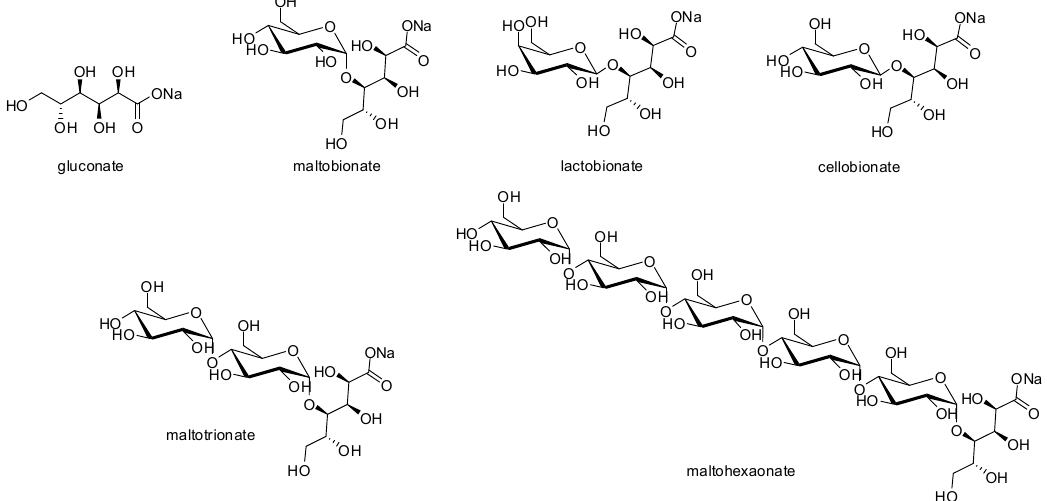
Figure 5. Products obtained by photocatalytic selective oxidation of various oligosaccharides after 10 min of standardized sunlight illumination (A.M.1.5G) from M. Omri et al. [43].